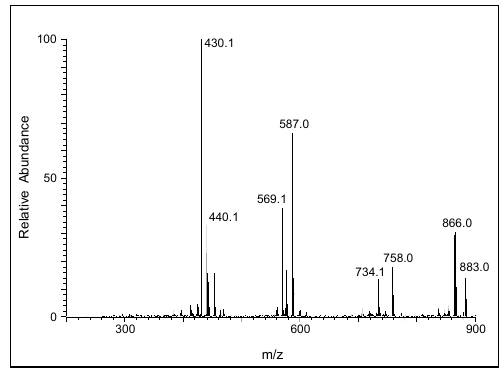
Figure 10. The CID mass spectrum of the ion with an m/z value of 883 amu.